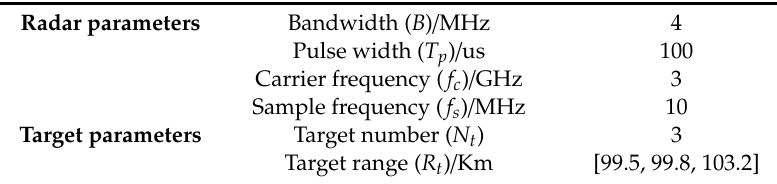
Table 1. Simulation